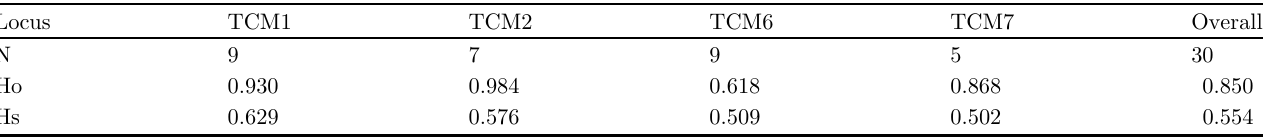
Table 4. Genetic diversity index at each locus